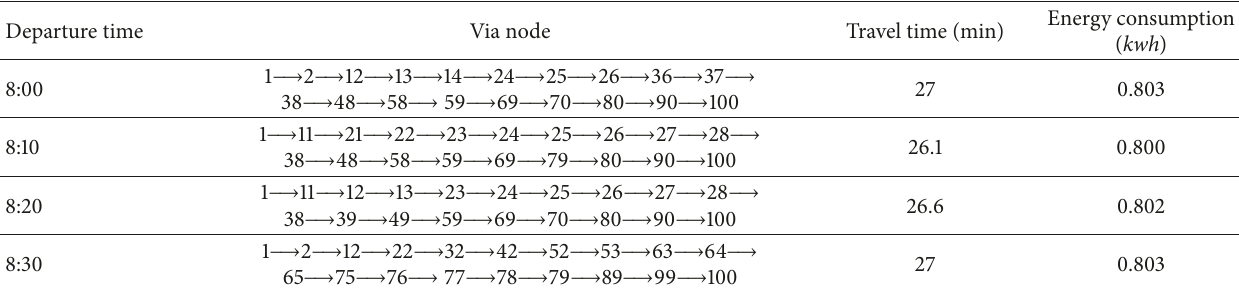
Table 8: The shortest routes from node 1 to node 100 at different departure time (in Scenario